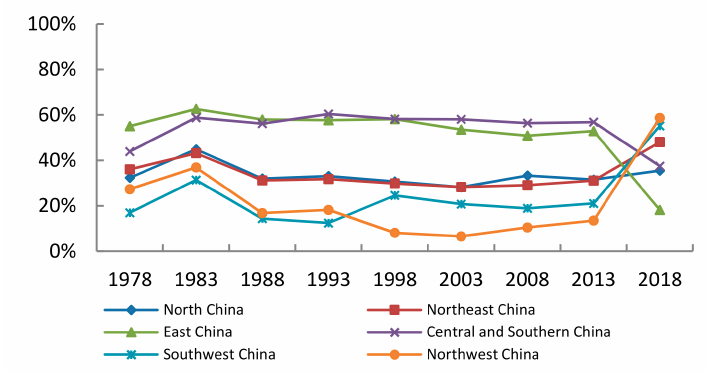
Figure 3. Changes in the contribution of resilience